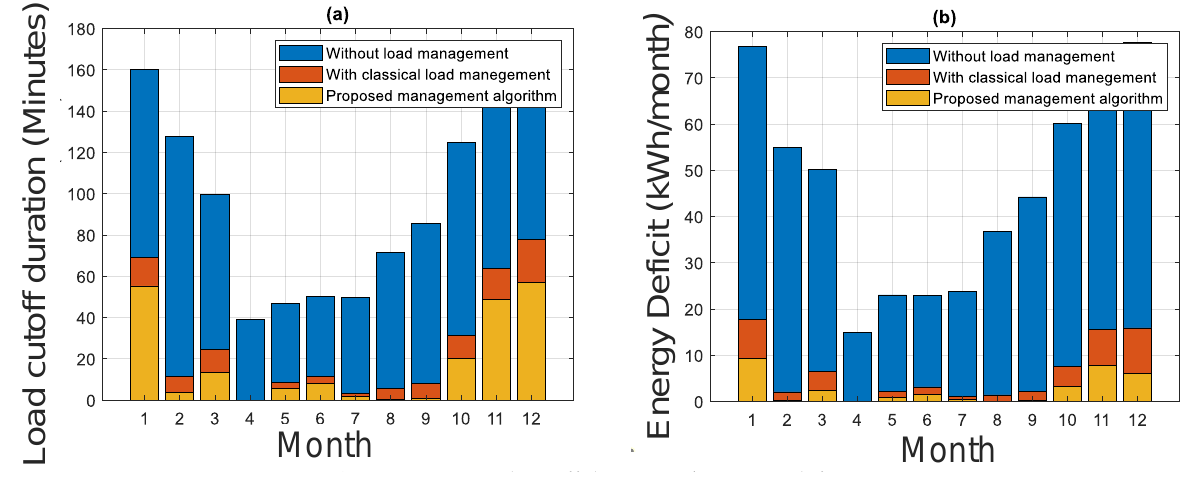
Figure 12. ( a ) Load cutoff duration, ( b ) energy deficit.